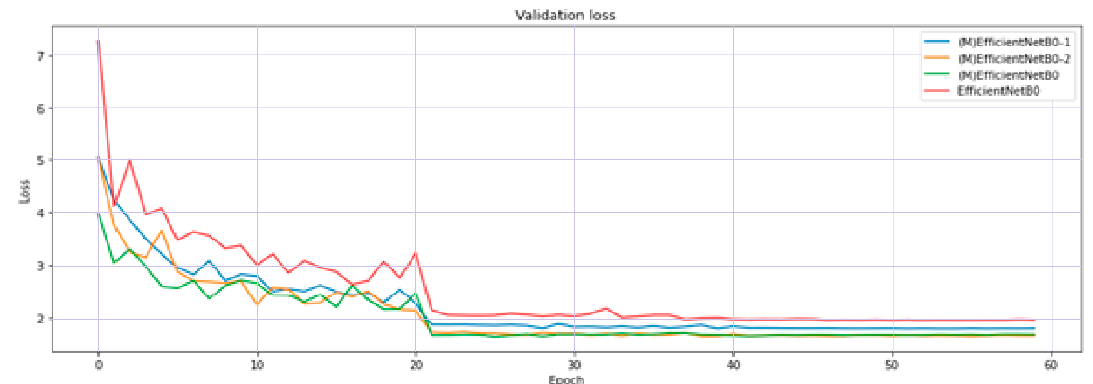
Figure 14. Validation loss comparison between EfficientNet B0 and our modification based on EfficientNet B0 (3 models); EfficientNet B0 is the base model; (M) EfficientNet B0 is our modification model, add blocks are added that connect all blocks similar to DenseNet (Figure 3.b); (M) EfficientNet B0-1 has only connections between consecutive blocks (Block N - Block N+1); (M) EfficientNet B0-2 has connections between consecutive blocks and blocks separated by 1 block (Block N – Block N+1; Block N – Block N+2).